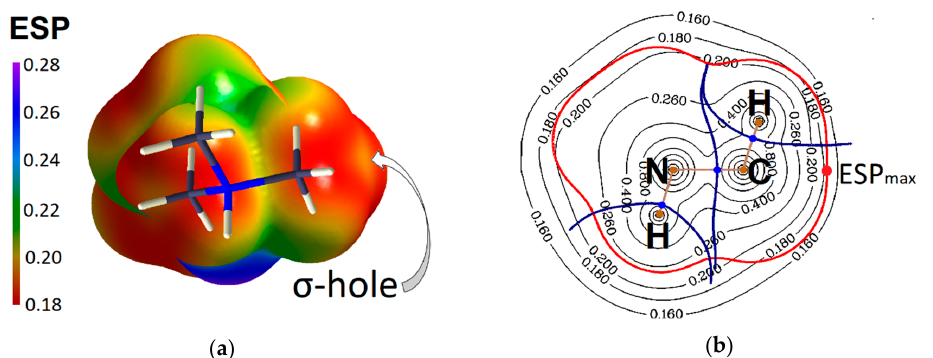
Figure 3. ( a ) ESP in the trimethylammonium cation on the isosurface of electron density of 0.003 a.u.; ( b ) contour map of ESP in the plane N-C-H, red point indicates the maximum of ESP on the van der Waals surface (red line) and belongs to C atomic basin.